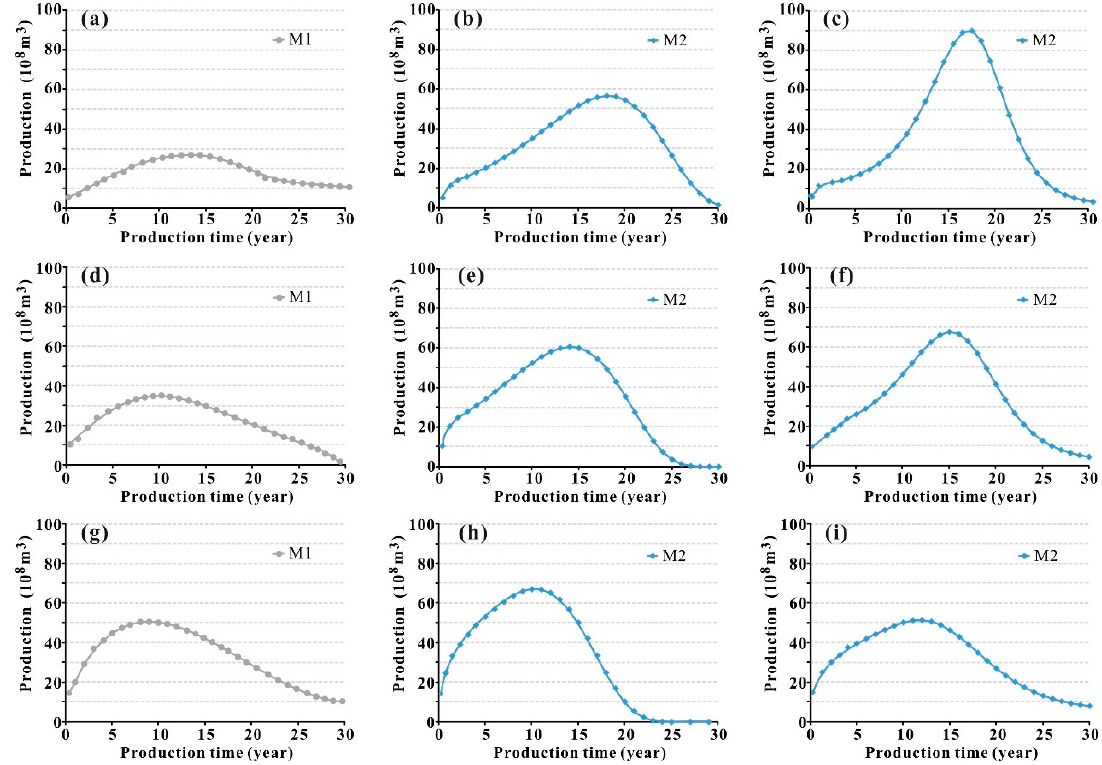
Figure 8. Best estimated gas supply under different IP and price scenarios. ( a ) IP1-P1; ( b ) IP1-P2; ( c ) IP1-P3; ( d ) IP2-P1; ( e ) IP2-P2; ( f ) IP2-P3; ( g ) IP3-P1; ( h ) IP3-P2; ( i ) IP3-P3.